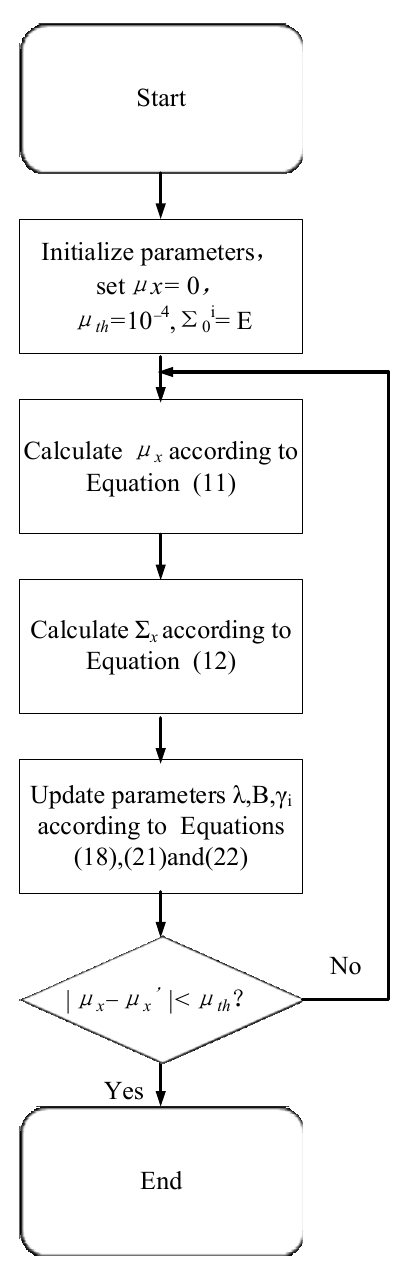
Figure 1. Flowchart of the BSBL algorithm.